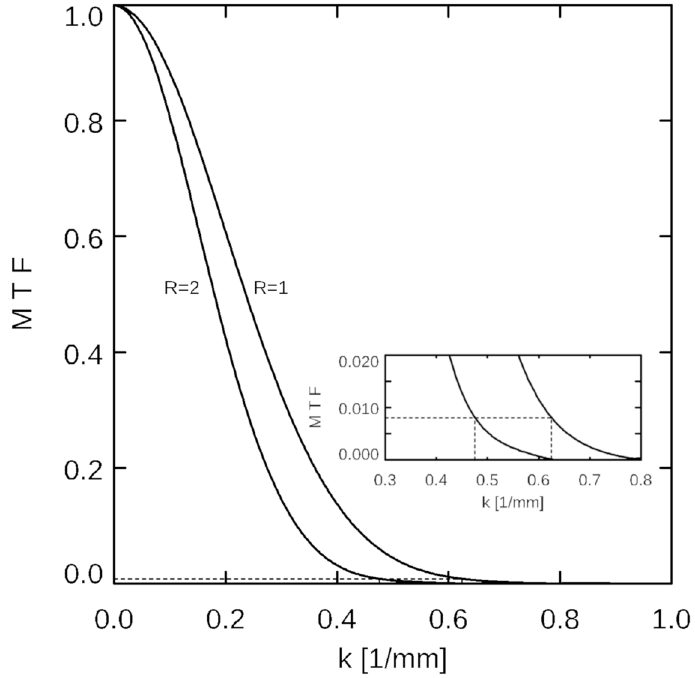
Figure 2. Illustration of the modulation transfer function (MTF) analysis. MTFs in the phase encoding direction are shown against wavenumber k for acceleration factors R = 1 and R = 2, for compressed sensing- (CS-) reconstructed HiSS MRI data. At k n = 0.625 1/mm (corresponding to the nominal in-plane resolution of 0.8 mm), the corresponding MTF value at R = 1 is 0.0081. For R = 2, this MTF value corresponds to k = 0.48 1/mm (see inset) or an equivalent resolution of 1.05 mm.